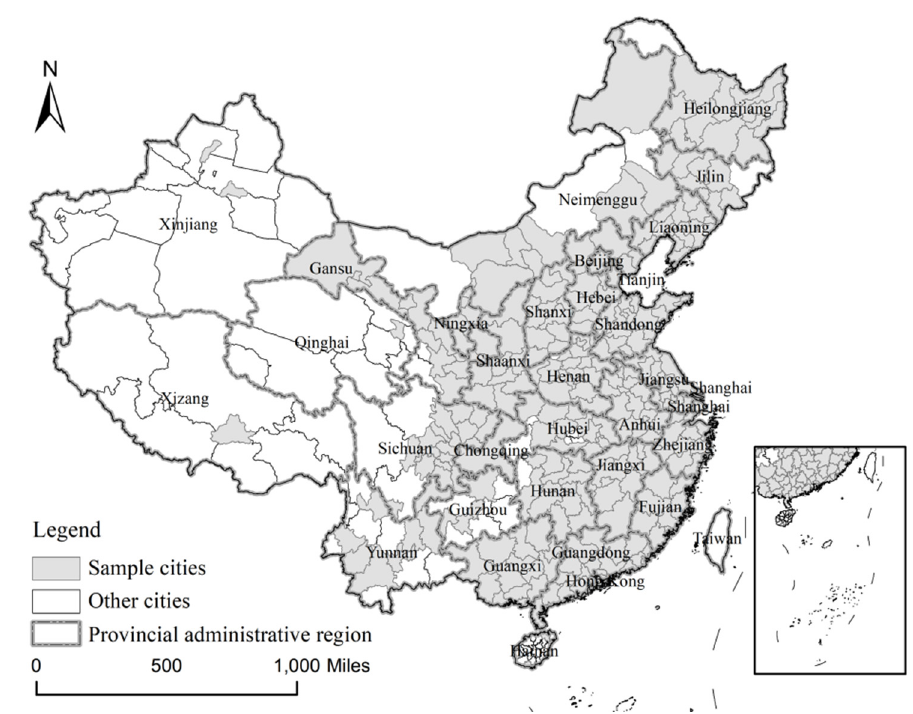
Figure 1. Study area.